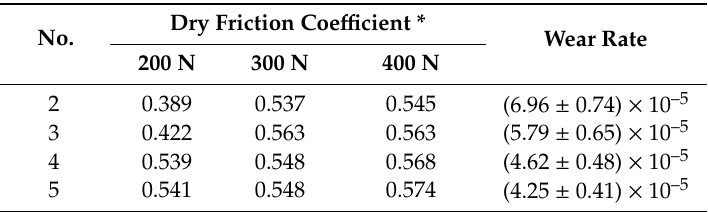
Table 3. The dry friction coe ffi cient and wear rate (the average at the three di ff erent test loads) for the test sample